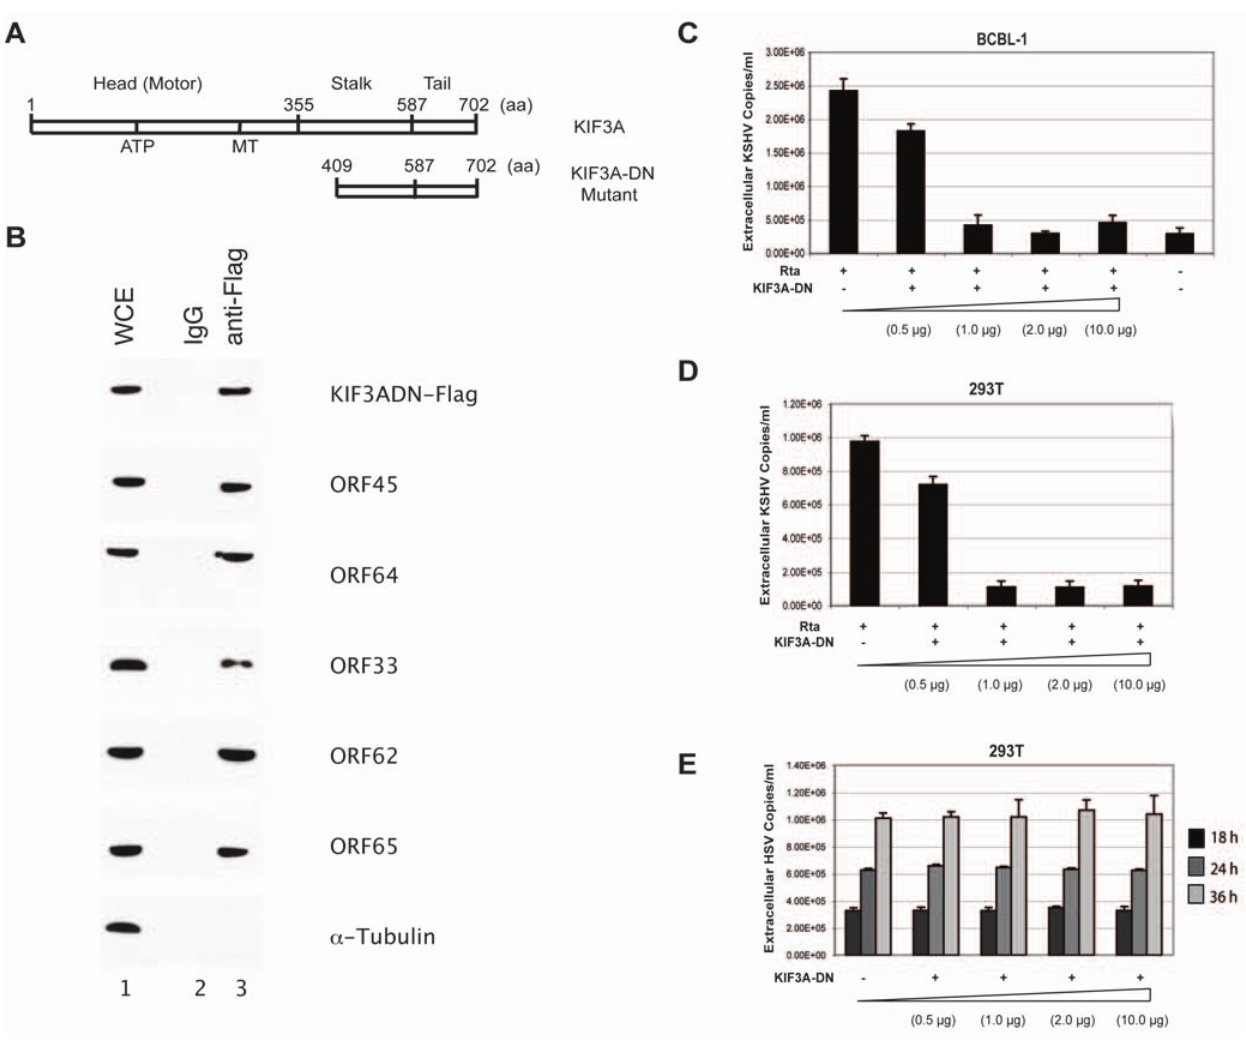
Figure 6. Functional significance of KIF3A-ORF45 interaction. (A) Schematic representation of the wild-type (full-length) and the dominant negative (DN) mutant of KIF3A. (B) Association of KIF3A DN mutant with KSHV tegument-capsid complexes. BCBL-1 cells were electroporated with the KIF3A-DN mutant plasmid along with the RTA-expression vector. Forty-eight hours post-transfection, whole cell extracts (WCE) were immunoprecipitated with mouse IgG (negative control) or anti-flag M2 Affinity gel. The immunoprecipitates were subsequently analysed by Western blotting with antibodies against flag tag, capsid, and a -tubulin proteins as indicated. (C) Increasing concentrations of the KIF3A DN mutant expression plasmid were electroporated into BCBL-1 cells along with 10 m g of pCR3.1-ORF50 or (D) transfected into 293T cells followed by KSHV infection and subsequent TPA induction. Extracellular KSHV virions were collected and concentrated 100-fold. Virus stocks were treated with Turbo DNaseI, viral DNAs extracted, and KSHV genomic DNA concentration estimated by a real-time PCR along with external standards of known concentrations of the viral DNA with primers against the ORF73 gene. Viral titers were expressed as viral DNA copy numbers per milliliter (ml) of the supernatant. (E) 293T cells were transfected with increasing concentrations of the KIF3A DN mutant and infected with HSV-1. Extracellular virions were collected at three different time-points (18, 24, and 36 hours post-infection), and the HSV-1 genomic DNA was extracted and quantitated by a real-time PCR along with external standards of known concentrations of the viral DNA with primers directed against the UL30 gene and expressed as the respective viral DNA copy numbers per ml of the supernatant. Viral titers obtained from the 18, 24, and 36 hour time-point samples are represented as black, light grey, and dark grey bars,